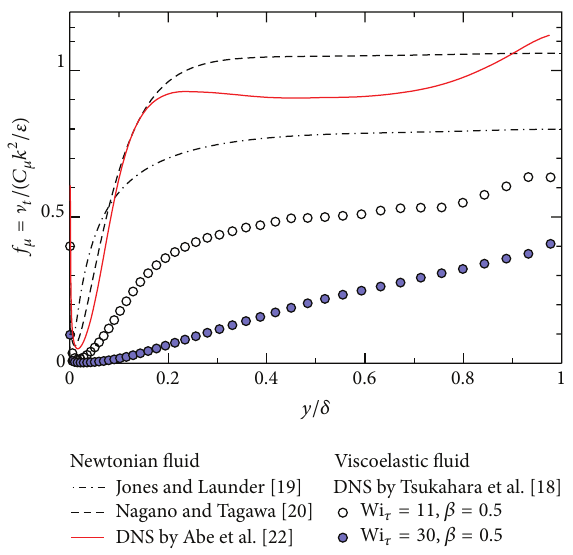
Figure 1: Comparison of damping function 𝑓 𝜇 for turbulent chan- nel flow at Re 𝜏 = 395